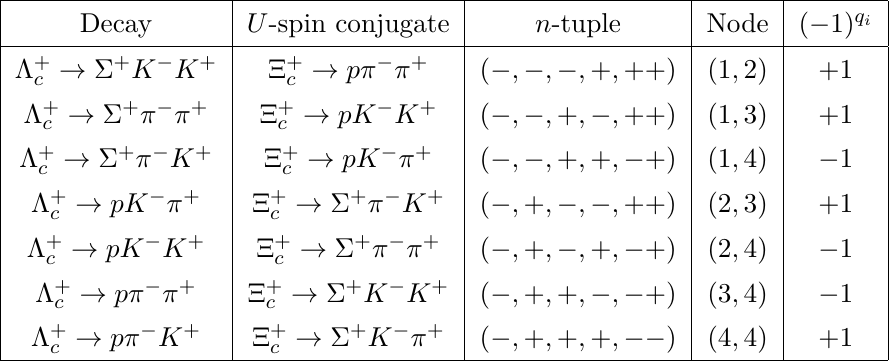
Table 5 . The mapping of the U -spin pairs of baryonic charm decays C b → L b P − P + decays into generalized n